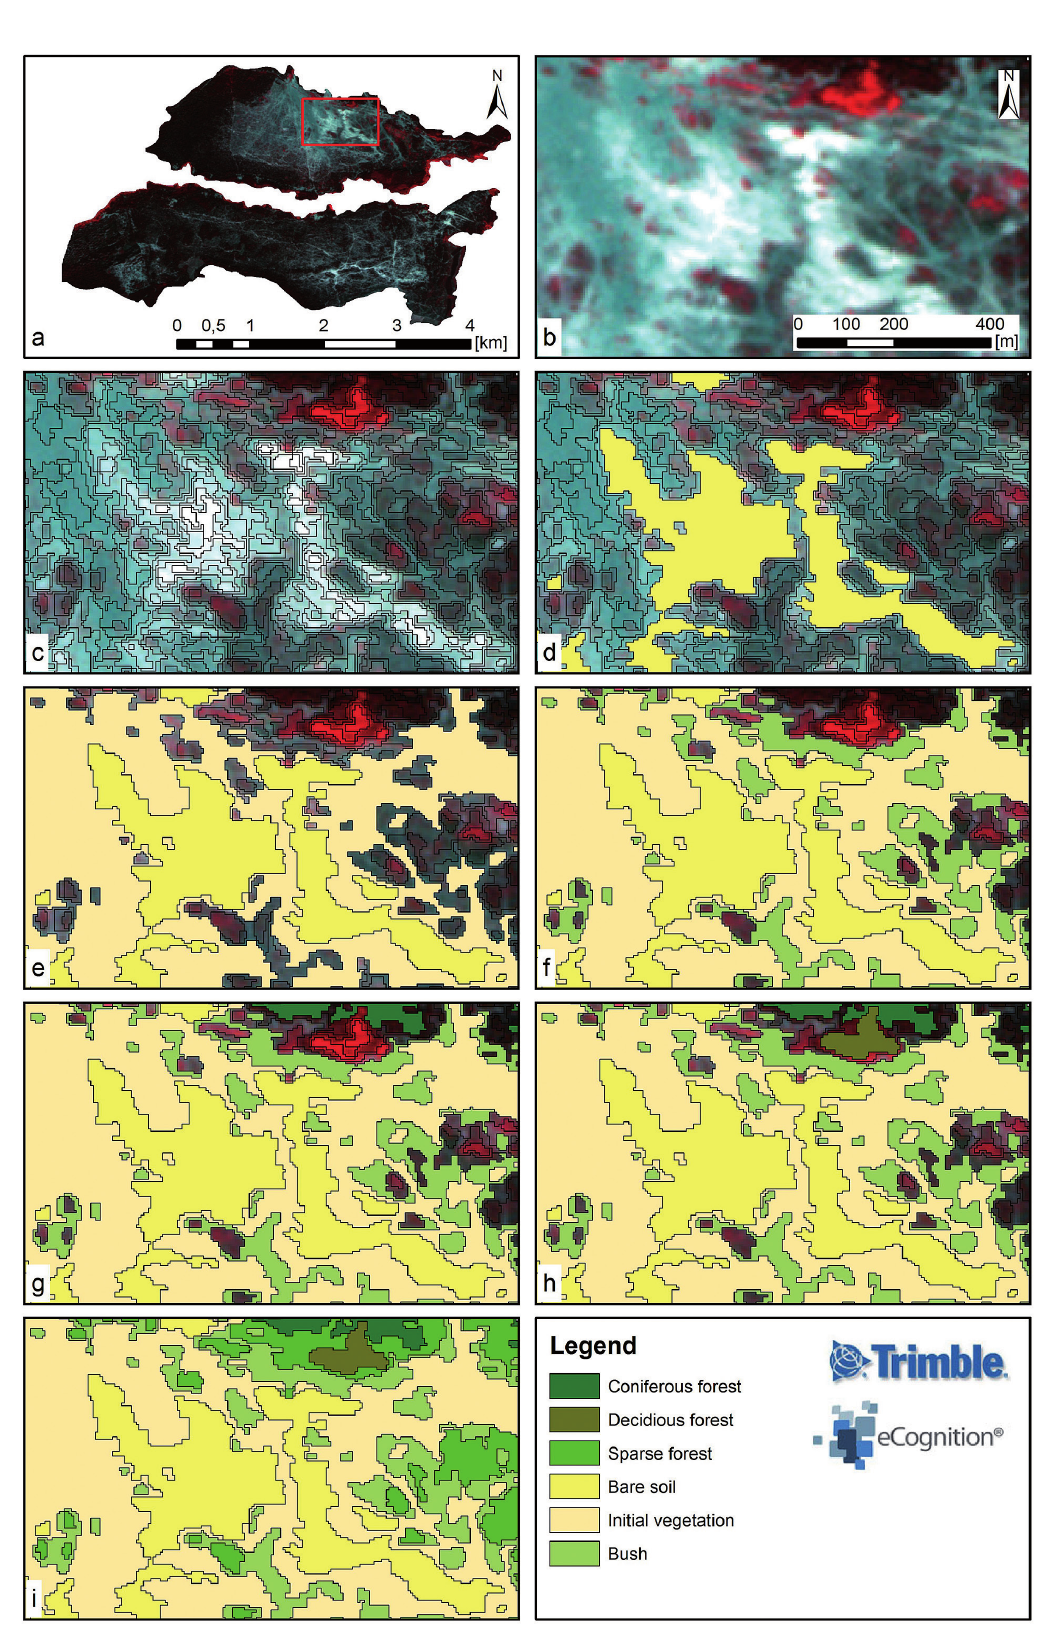
Fig. 5. The steps of the GEOBIA approach: a) an example of AOI (red) processed with OBIA; b) enlarged AOI (Rapid Eye); c) image segmentation (start of GEOBIA); d) bare soil; e) initial vegetation; f) bush; g) coniferous forests; h) deciduous forests; i) sparse forests (end of